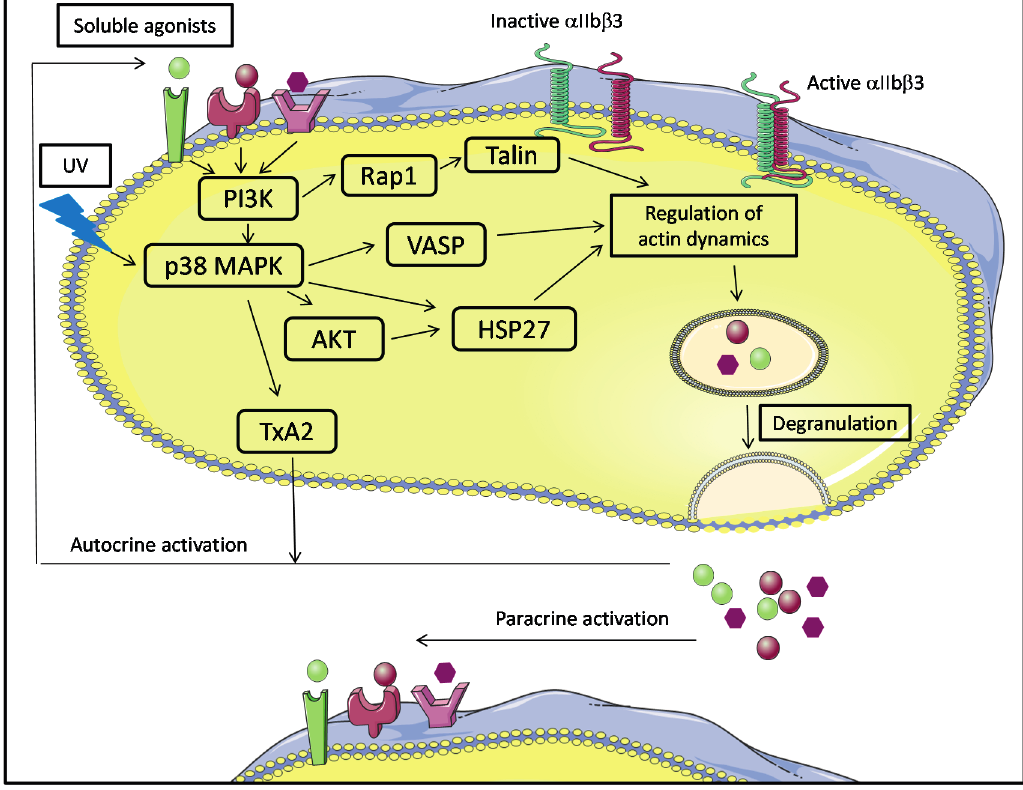
Figure 4. Principal signaling pathways inducing platelet activation in platelet components. Phosphoinositide 3-kinase (PI3K), mitogen-activated protein kinase (MAPK), protein kinase B (AKT), Thromboxane A2 (TxA2), Vasodilator-stimulated phosphoprotein (VASP), Ras-proximate-1 (Rap1), Heat shock protein 27